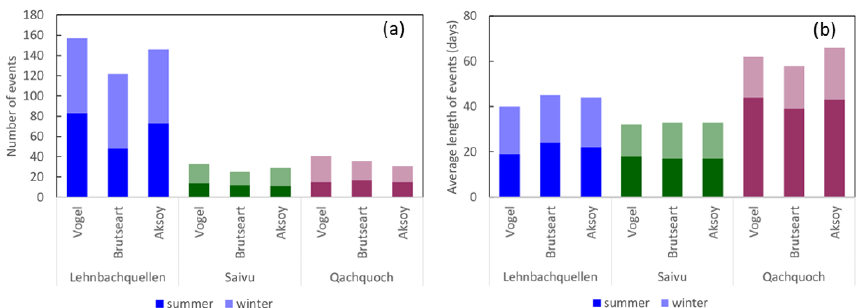
Figure A2. Characteristics of extracted recession events by REMs for both winter and summer periods at the three study sites: (a) number of identified complete recession events and (b) the average number of days when complete recession occurred.